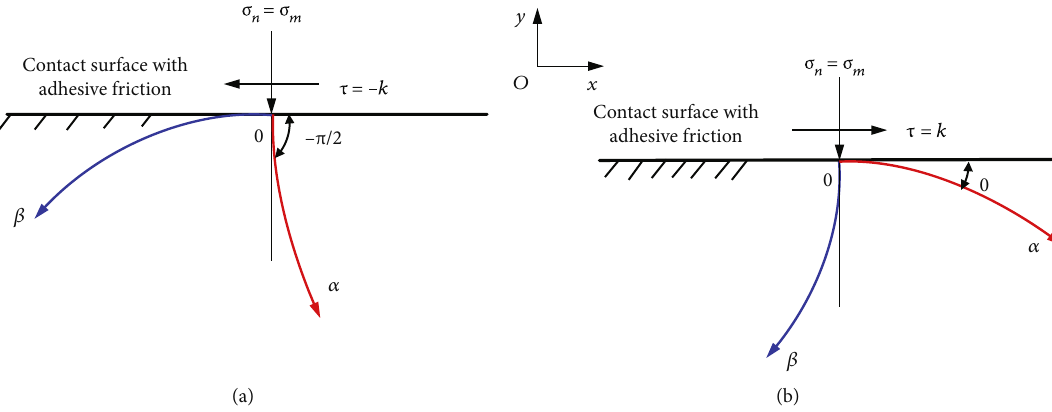
; (b) normal stress is σ . 1 3